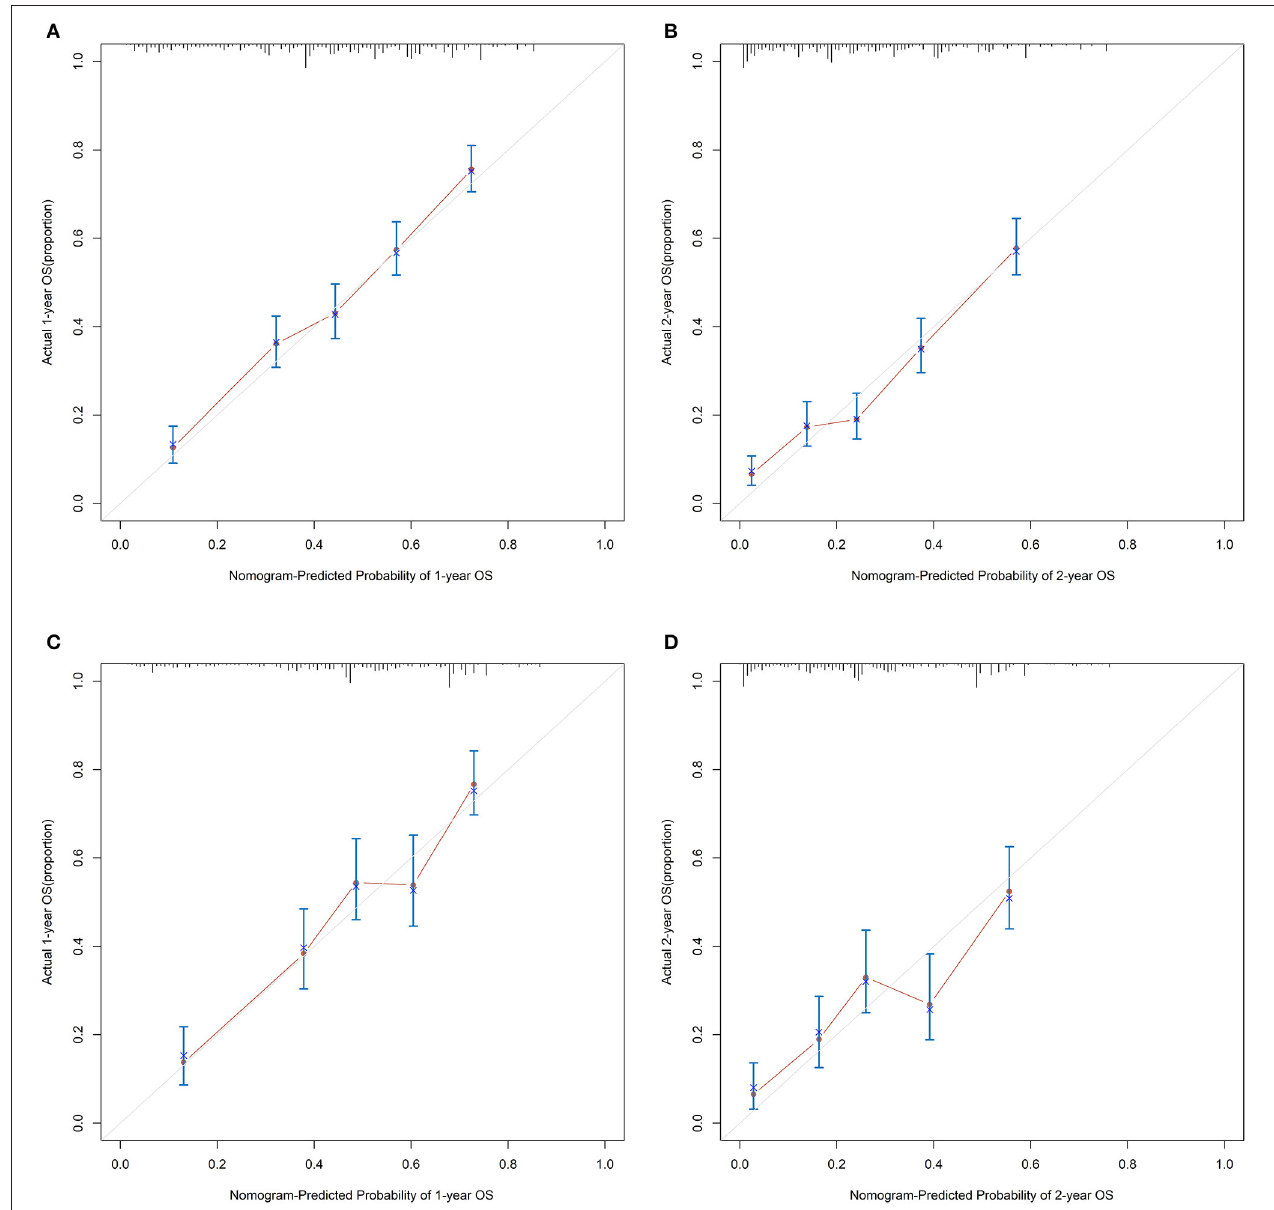
FIGURE 2 | The calibration curves for predicting patients’ OS at 1- and 2-year in the (A,B) training group and (C,D) validation group,